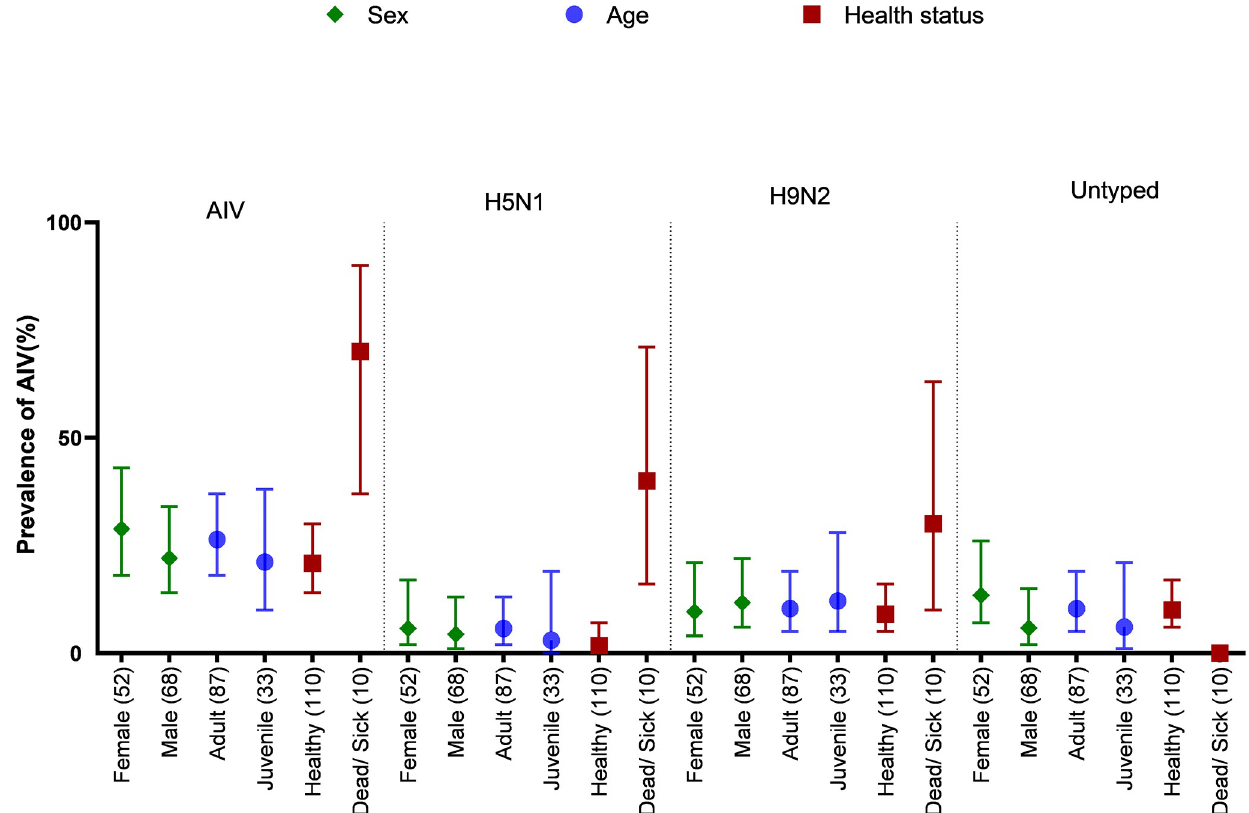
Fig 2. Prevalence and 95% CI of Influenza A, H5N1, H9N2, and Influenza A/Untyped in sub-samples (sex, age, health status).